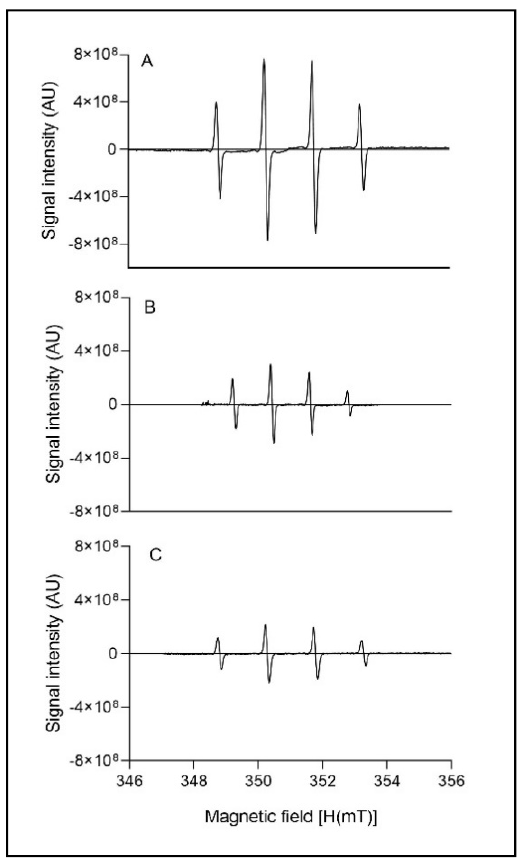
Figure 3. EPR signal intensity of the DMPO-OH radical adduct measured without extract or black line ( A ), with ‘Grazia’ berry extract (0 DAF) ( B ), and ‘Grazia’ leaves extract (O DAF) ( C ).